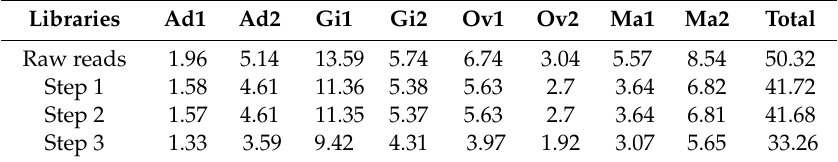
Table 2. Counts of filtered sequencing reads (in millions) for the small RNAs from di ff erent tissues.